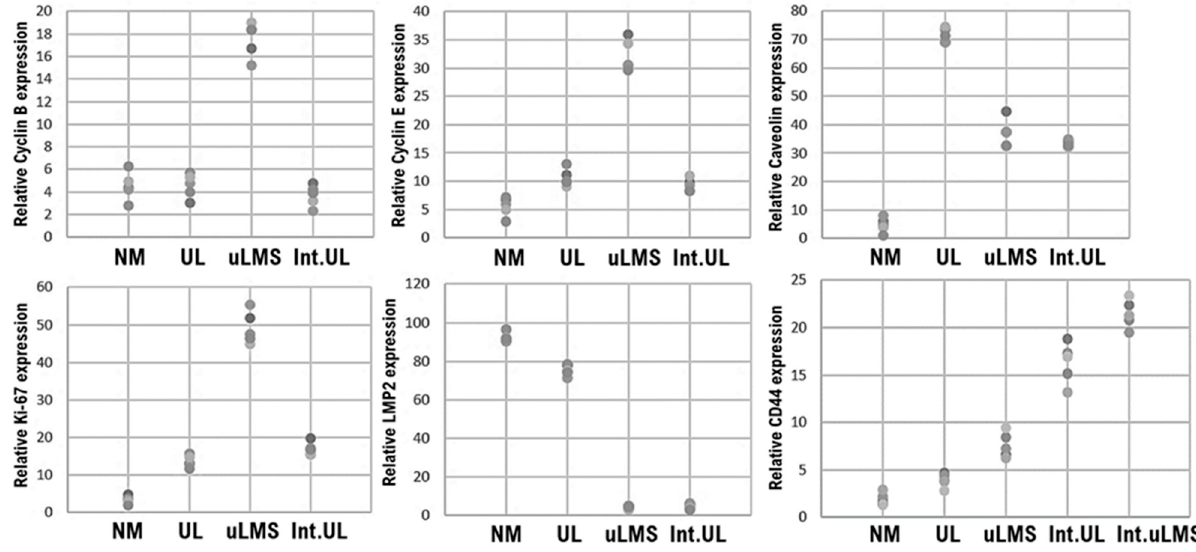
Figure 4. CD44-positive uterine mesenchymal tumor stem-like cells in intravenous leiomyomatosis and intravenous uter- ine leiomyosarcoma. Immunohistochemistry of normal myometrium, uterine leiomyoma, uterine leiomyosarcoma, intra- venous leiomyomatosis, and intravenous leiomyosarcoma tissues was performed using appropriate monoclonal antibod- ies with standard procedures. The five tissue sites were randomly selected: normal myometrium, uterine leiomyoma, uterine leiomyosarcoma, internal tissue of intravenous leiomyomatosis, and intravenous leiomyosarcoma. In a 40× field of view, the positive rates of the six factors were calculated in the five tissue sites under microscopy (Panthera Shimadzu Co. Ltd., Kyoto, Japan); the positive rates at the sites of each tissue are shown in the scatter plot. Int.UL: Intravenous leiomyomatosis, Int.uLMS: Intravenous uterine leiomyosarcoma. Int.uLMS: Intravenous uterine